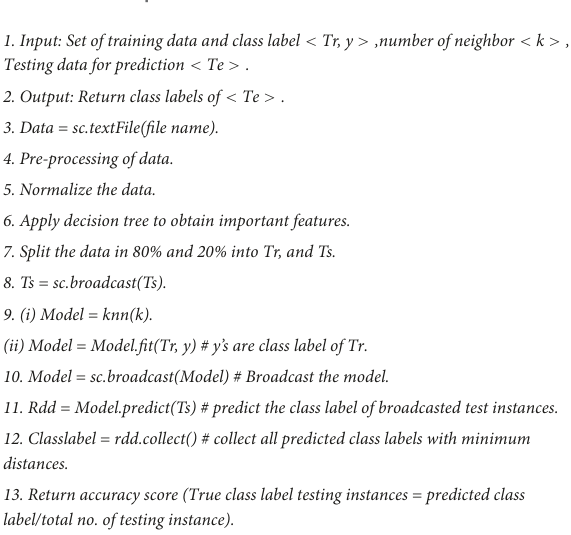
Implementation on spark platform